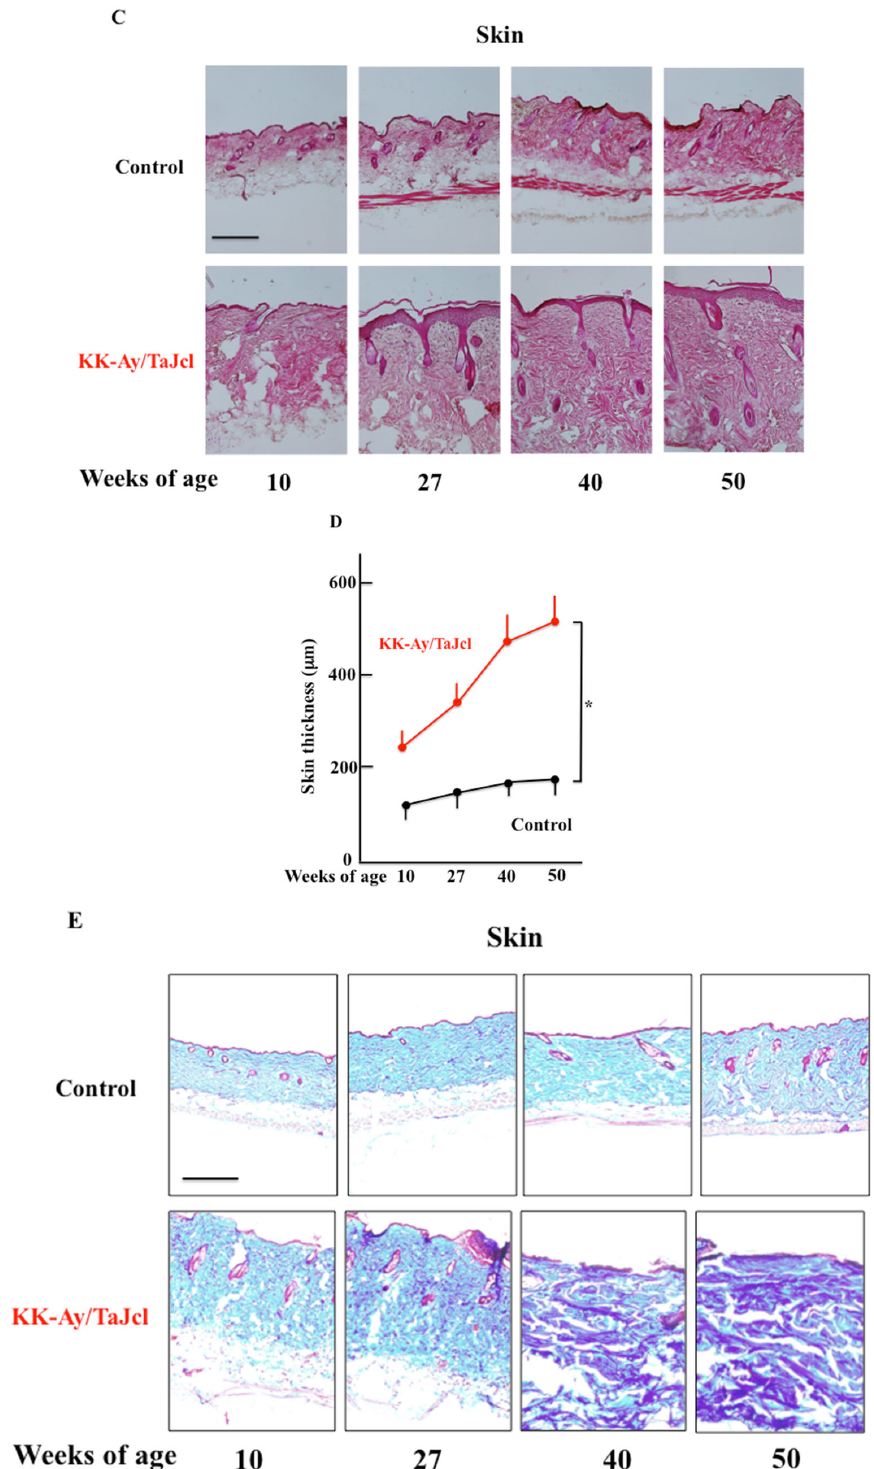
Figure 2. Effect of aging on transept water loss ( A ), skin hydration ( B ), and skin thickness ( D ) in KK ‐ Ay/TaJcl mice. Histological analysis of skin sections was performed using hematoxylin–eosin ( C ) and Masson ‐ trichrome (collagen stain) ( E ) staining. Values are expressed as the mean ± SD of five animals. * p < 0.05. Control: C57BL/6j mice. Scale bars (length unit display) = 100 μ m.